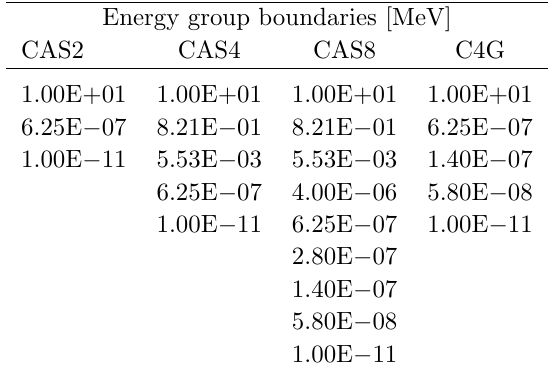
Table 7. Energy grids used for group constant